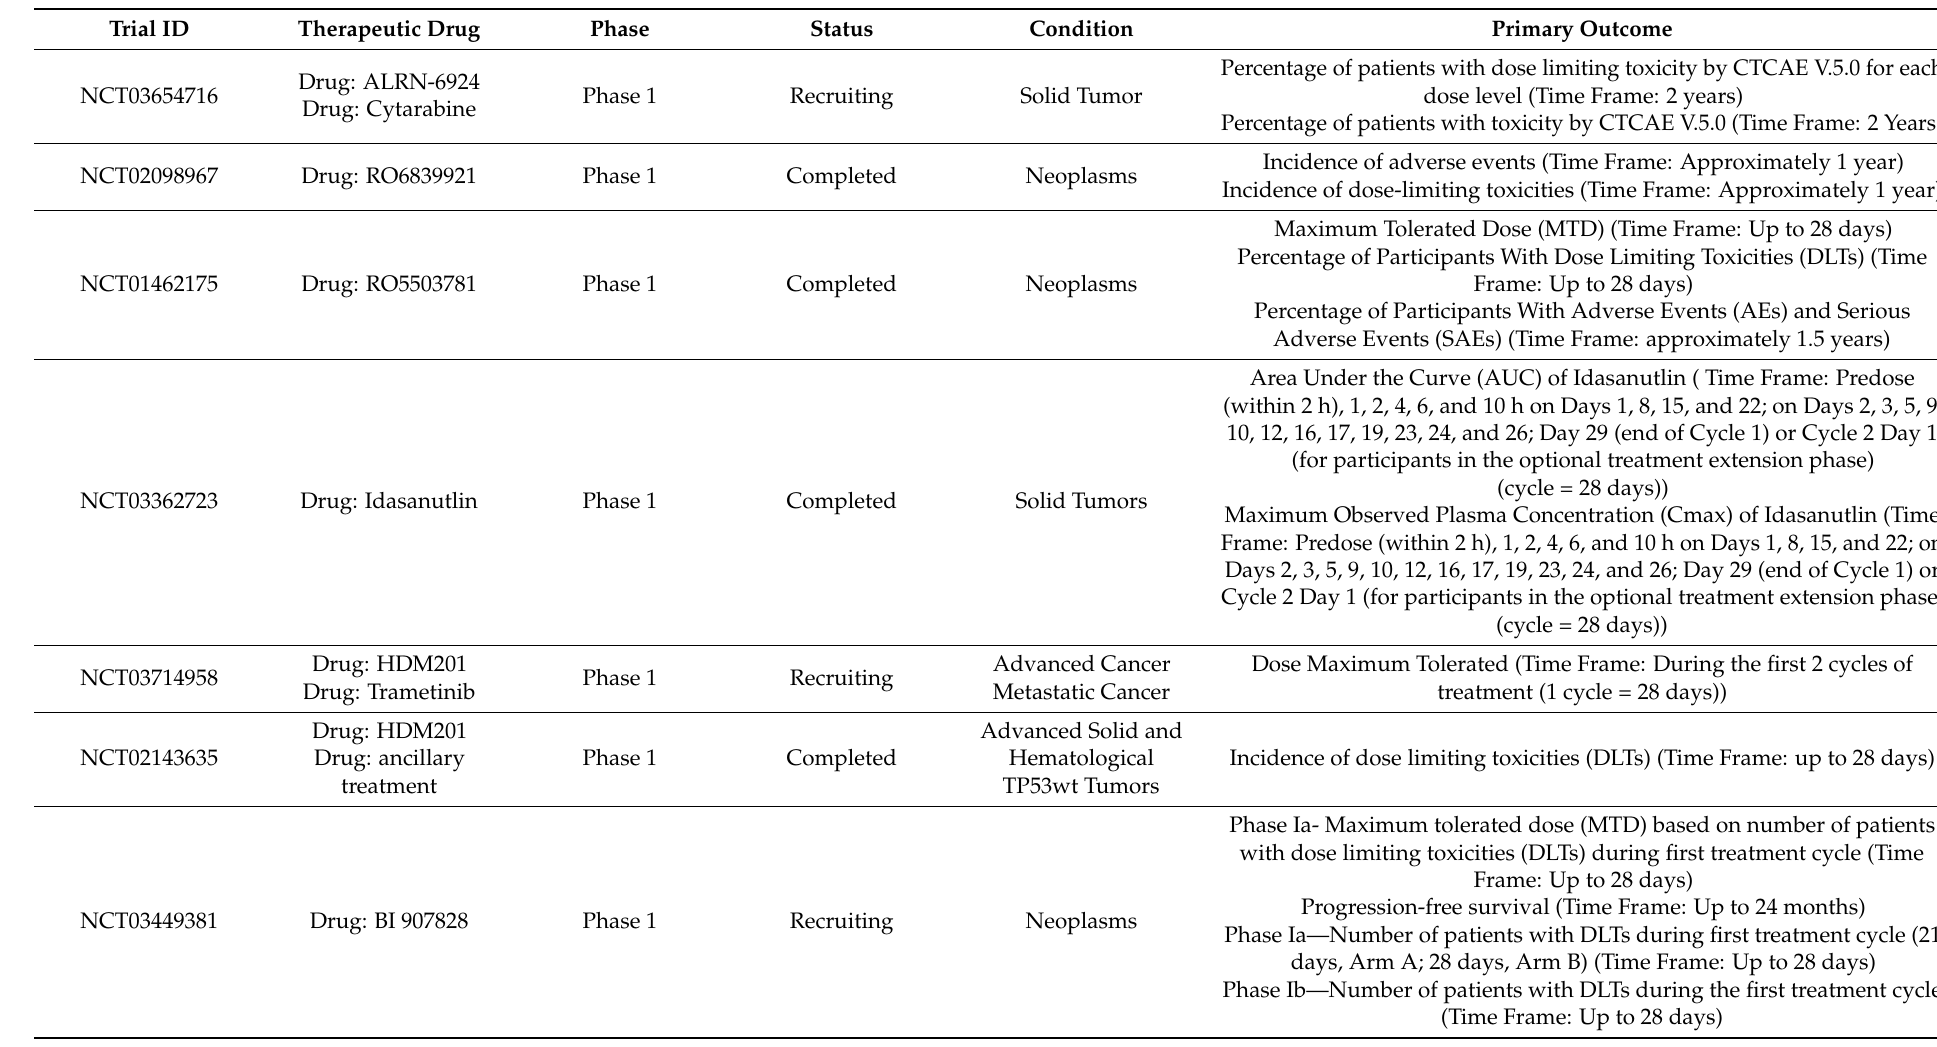
Table 1. Recent clinical trials of MDM2 inhibitors in human pancreatic